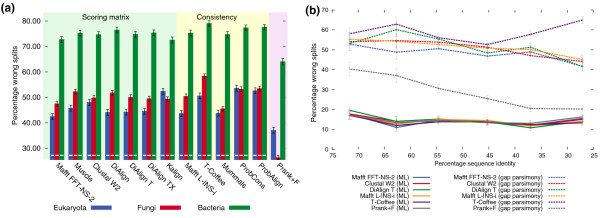
Phylogenetic signal of gaps. (a) Assessment of gap accuracy under default parameters using the species-tree discordance test with parsimony trees on presence/absence patterns of gap characters in aminoacid alignments. By taking into account gap information, this test demonstrates that the gap placement of Prank is significantly better than other alignment methods. This cannot be observed either using standard tree building methods (Figure 2), or using structure-based benchmarks. Error bars correspond to ± 1 s.d. Significant difference from Prank is denoted with a minus symbol at the basis of relevant bars (Wilcoxon double-sided test, P < 0.01). (b) Accuracy of maximum likelihood (ML) trees on amino-acid substitution patterns versus parsimony on binary gap presence/absence characters, on fungal data. The phylogenetic signal of gaps inferred by Prank increases with divergence. For distant sequences, the proportion of correctly inferred splits from gaps alone is close to that from amino-acids substitutions by ML. Thus, tree building methods could capture up to twice as much phylogenetic signal from the same data. Moreover, note that the crude approach used here to infer the gap trees likely understates the potential of gap patterns.